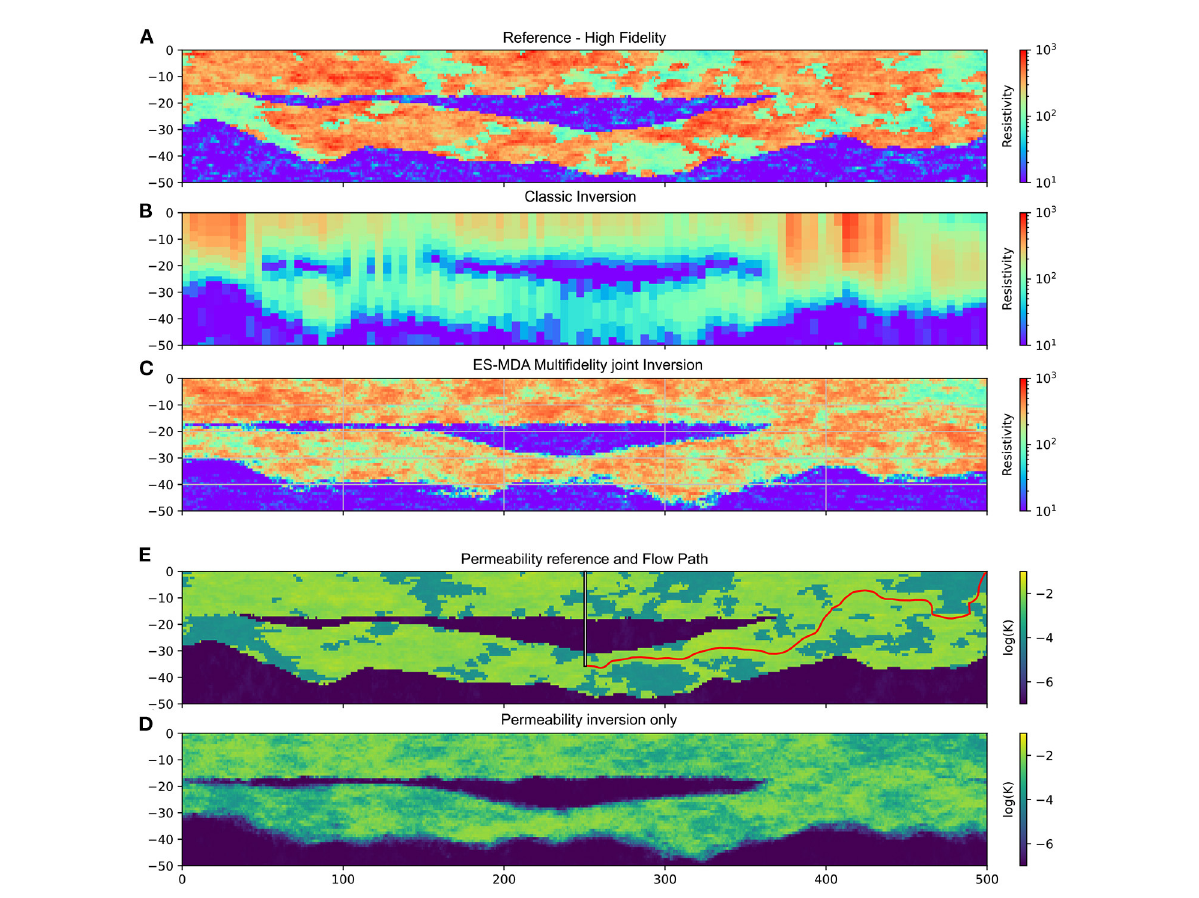
FIGURE8 High-fidelity results for model C2. (A) Reference field for resistivity. (B) Resistivity field from a deterministic inversion. (C) ES-MDA inverted resistivity field. (D) Reference field for hydraulic conductivities with are well and the simulated steady-state flow line. (E) Mean model for an application of the ES-MDA algorithm on hydraulic conductivities